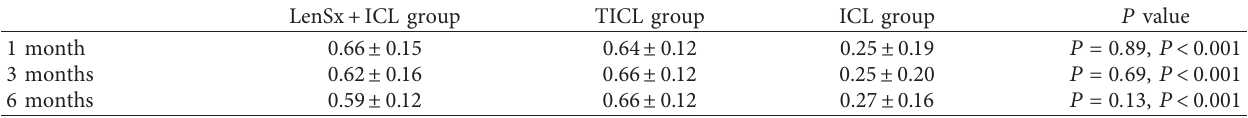
Table 3: CI in three groups after surgery.